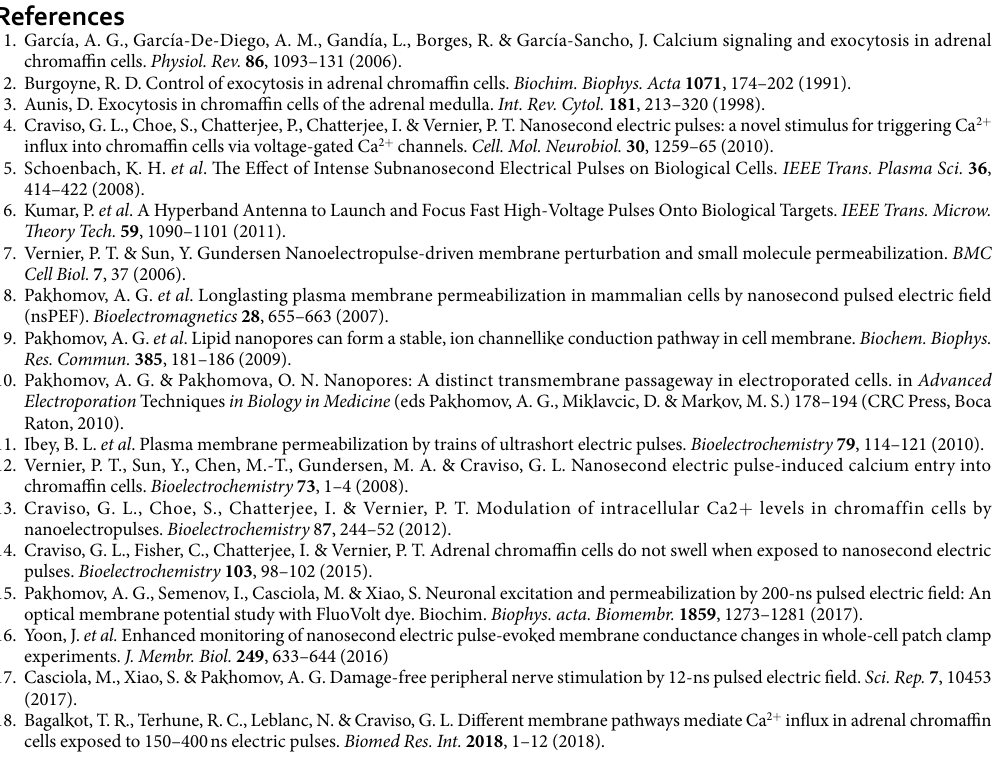
Image processing and data analysis. Fluorescence images for each cell were continuously recorded during a period spanning 10 s prior to nsPEF exposure to obtain baseline, and then for a period spanning 50 s after nsPEF exposure. Images were analyzed using the public domain image processing software ImageJ (https:// imagej.nih.gov/ij/). Changes in cell fluorescence intensity ( Δ F) were calculated by subtracting background flu- orescence from the fluorescence of the cell ( Δ F = F cell − F background ). The values were then normalized to the fluo- rescence intensity value at the time when the pulse was applied (F 0 ). All experiments were replicated using cells from different cell preparations and different days in culture. Results were expressed as the mean ± standard error of the mean (s.e.m.). Statistical analyses, which were performed using SigmaPlot 13 software (Systat software, Inc., San Jose, CA), consisted of an unpaired two-tailed t-test when the means of two groups were compared, or a one-way ANOVA test followed by Tukey post hoc multiple range tests for multiple group comparisons. p < 0.05 was considered statistically significant.